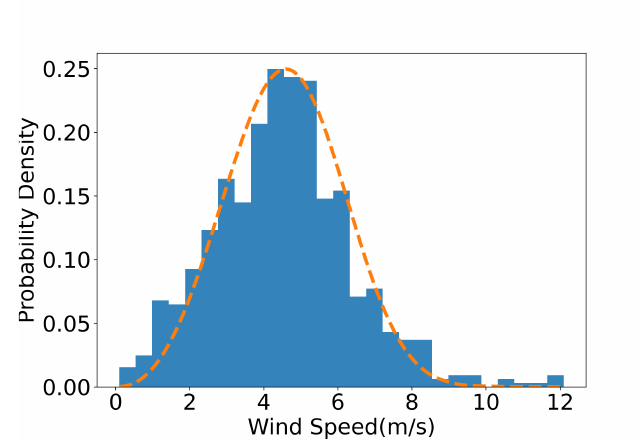
Figure 2. Probability distribution of wind speed in